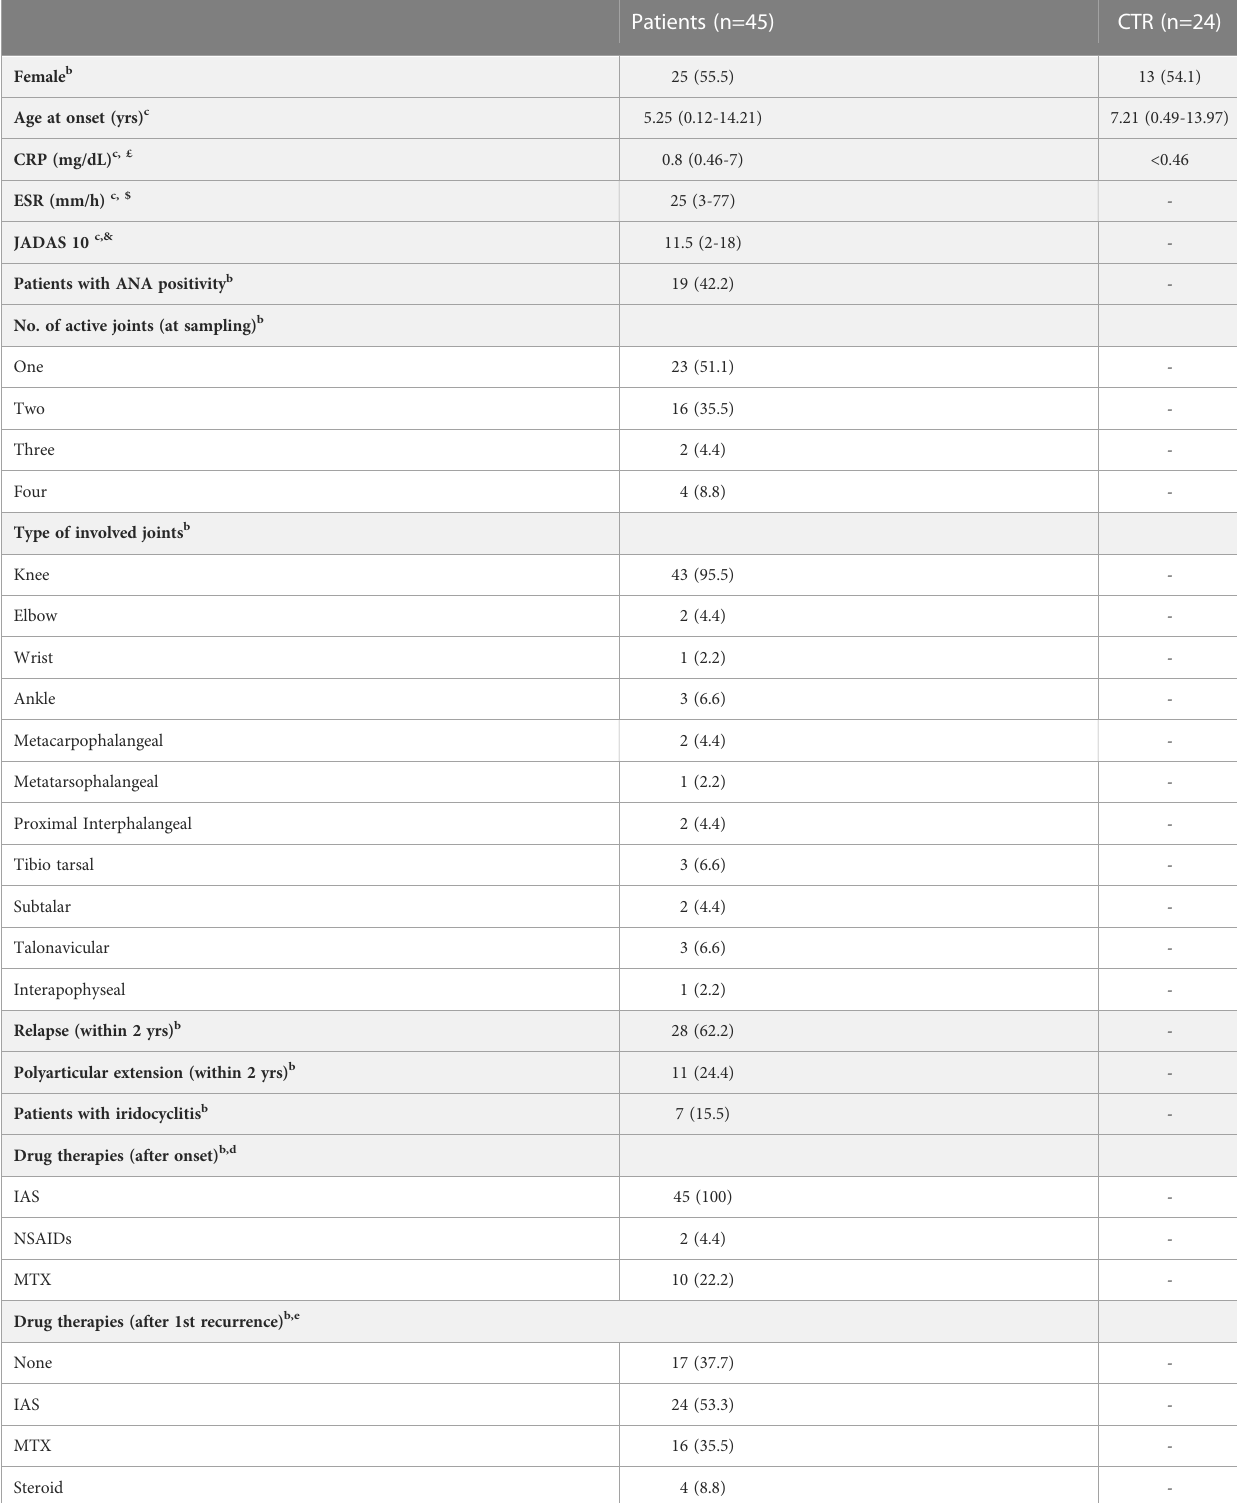
TABLE 1 Demographic, clinical, laboratory, and therapeutic features of OJIA patients at disease onset and follow up a